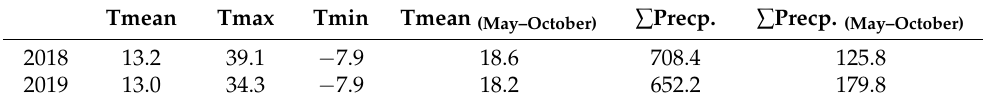
Table 4. Climate characteristics recorded during 2018 and 2019 at the weather station in Paradela, close to the experimental plot. Average annual temperature (Tmean, ◦ C), maximum temperature (Tmax, ◦ C), minimum temperature (Tmin, ◦ C), average temperature ( ◦ C) from the blossoming